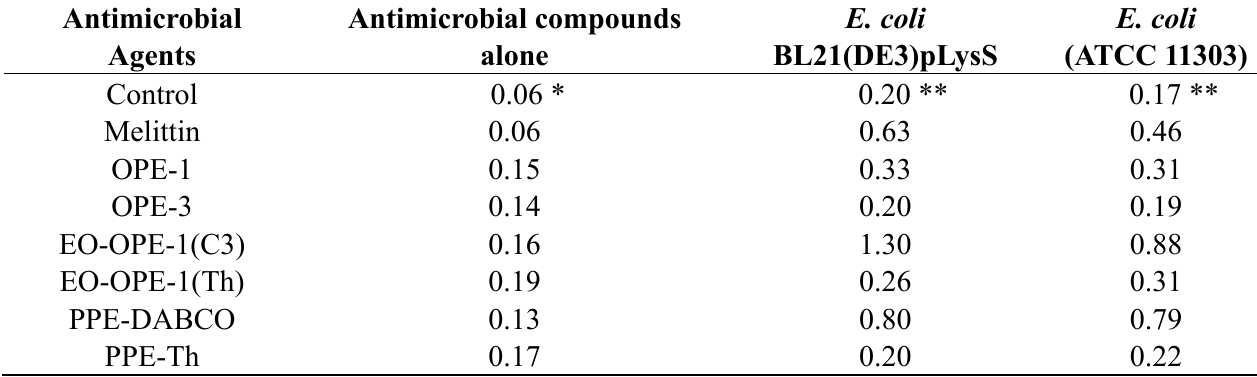
Table 1. Absorbance at 260 nm for the antimicrobial compounds and their mixture with soluble materials released from bacteria. The concentration of the antimicrobial compounds and E. coli cells are 10 µg/mL and 10 8 CFU/mL respectively. All samples were incubated at 37 °C for 1 hour in 10 mM PBS, followed by centrifuging at 10,000 rpm for 10 min. All experiments were done in the